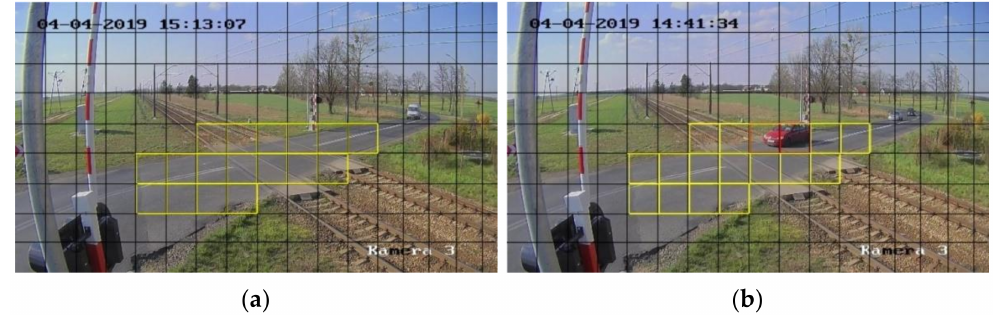
Figure 2. Image with the square grid: ( a ) safe passage for trains, ( b ) with objects. The size of the grid squares is determined by the requirements of object detection and parameters of the observation cameras. The smallest objects thatmay disrupt the safe passage of the train are taken to be of the size of a cube with 0.3 [m] sides. Cameras are